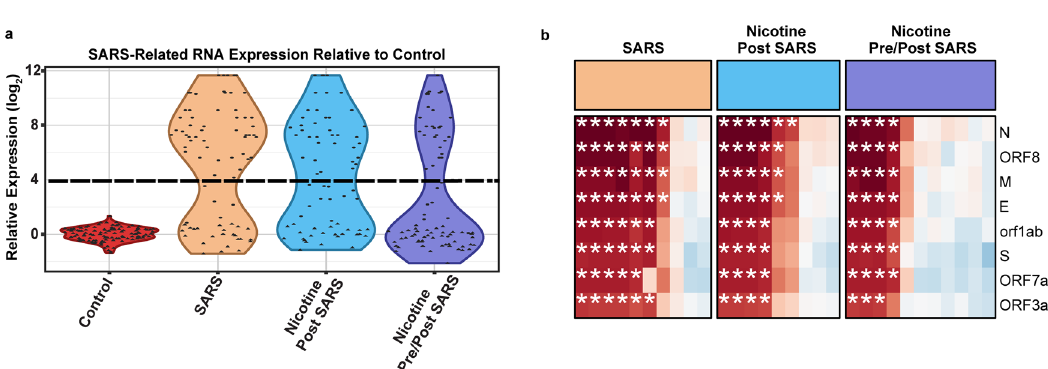
Figure 4. Nicotine exposure before SARS-CoV-2 inoculation reduced the likelihood of SARS-CoV-2 RNA expression in the brain. ( a ) Violin plots of SARS-Related RNA expression relative to Control. The dashed line indicates log2 threshold to define “responder” versus “non-responders”. Each dot indicates the relative expression of a SARS-CoV-2 related transcript; n = 9–11 mice per group with 8 transcripts each. ( b ) Quantile normalized log 2 changes in SARS-CoV-2-related transcripts in rows relative to control, for individual mice in columns. Asterisks represent expression above threshold defined in panel a. N encodes the SARS-CoV-2 N Protein (same for M, E, and